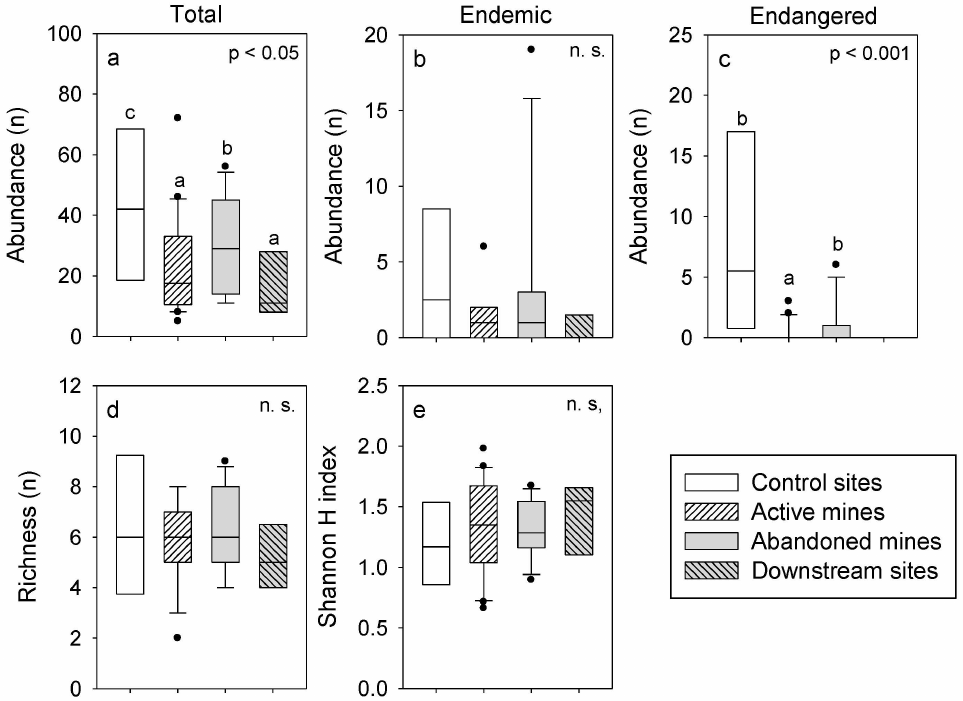
Figure 5. Boxplots of fish richness ( d ), abundance ( a ) = total fishes, ( b ) = endemic fishes and ( c ) = endangered fishes, and alpha diversity measured as the Shannon H index ( e ) at the study sites. Results of one-factor ANOVAs (location) and multiple comparisons with Tukey are also shown. There are no significant differences among locations with the same letter. Mean values and statistical analyses are detailed in Tables A4 and A5. ns means not statical